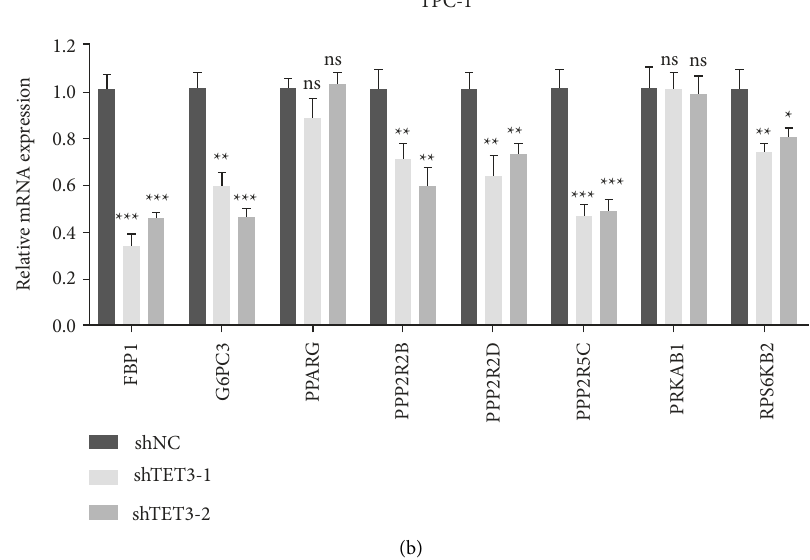
Figure 6: (a) and (b) qPCR was used to measure the mRNA expression levels of some AMPK pathway-related genes in PTC cells with or without TET3